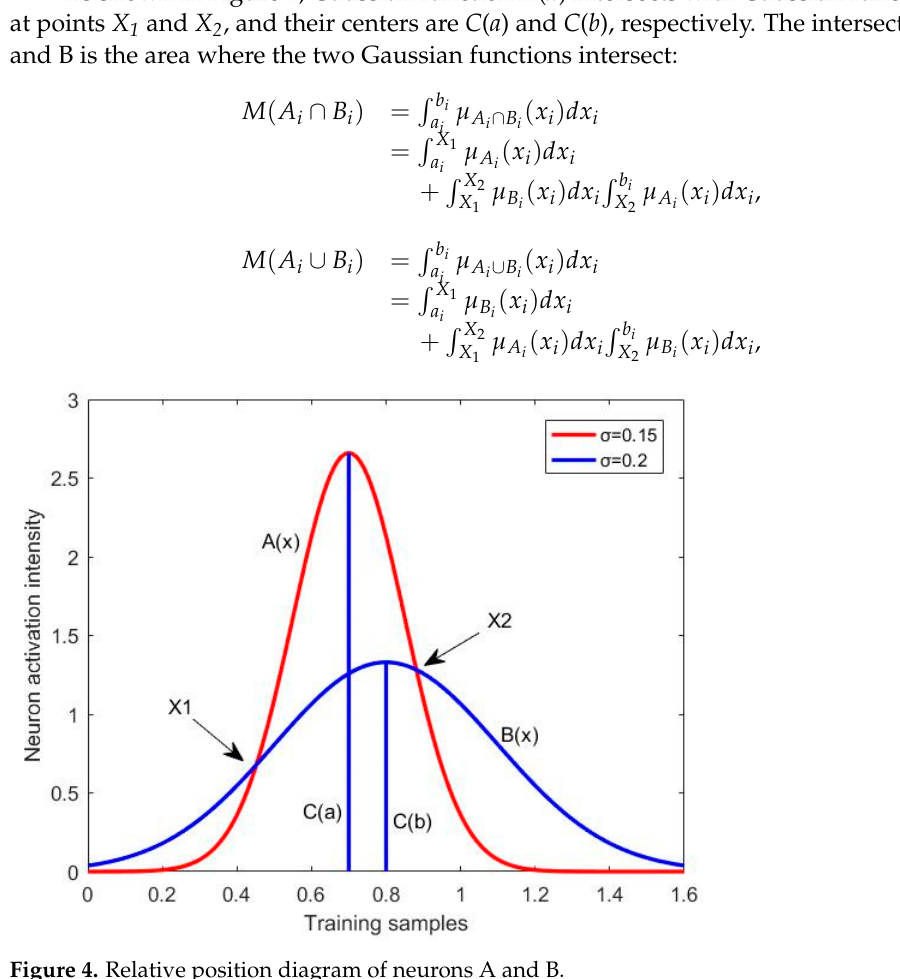
Figure 4. Relative position diagram of neurons A and B.